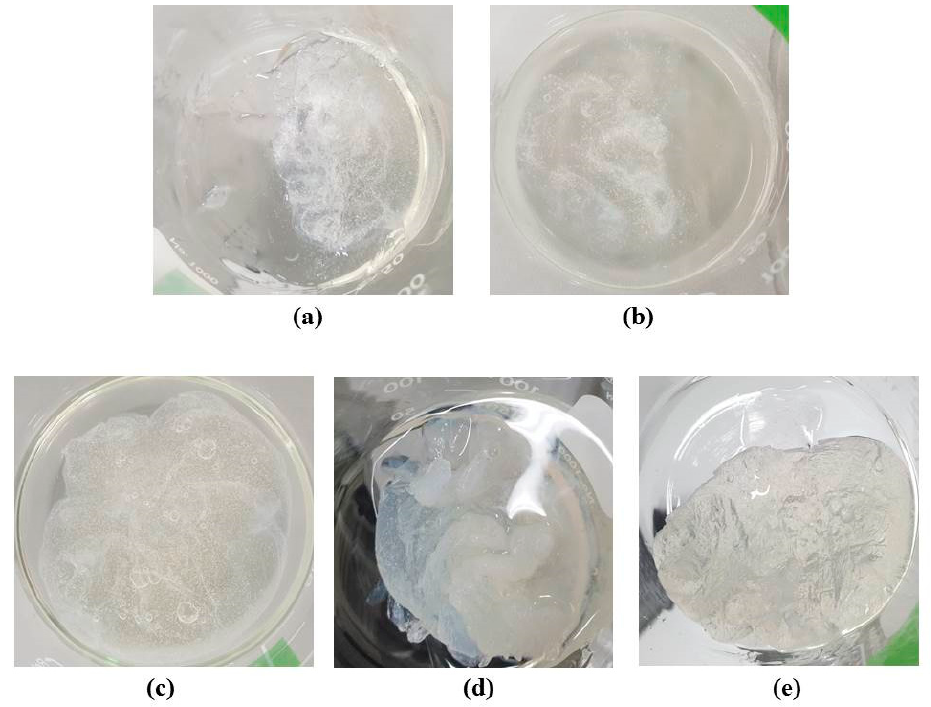
Figure 2. The di ff erence depending on the Cu 2 + and Al 2 (SO 4 ) 3 concentrations (( a ) 0.1% (Al 2 (SO 4 ) 3 ) Figure 2. The difference depending on the Cu 2+ and Al 2 (SO 4 ) 3 concentrations (( a ) 0.1% (Al 2 (SO 4 ) 3 ) without Cu 2 + , ( b ) 0.1% Al 2 (SO 4 ) 3 with Cu 2 + , ( c ) 0.3% Al 2 (SO 4 ) 3 with Cu 2 + , ( d ) 0.5% Al 2 (SO 4 ) 3 with without Cu 2+ , ( b ) 0.1% Al 2 (SO 4 ) 3 with Cu 2+ , ( c ) 0.3% Al 2 (SO 4 ) 3 with Cu 2+ , ( d ) 0.5% Al 2 (SO 4 ) 3 with Cu 2+ , Cu 2 + , ( e ) the solid phase after separation). Water 2020 , 12 , x ( e ) the solid phase after separation).